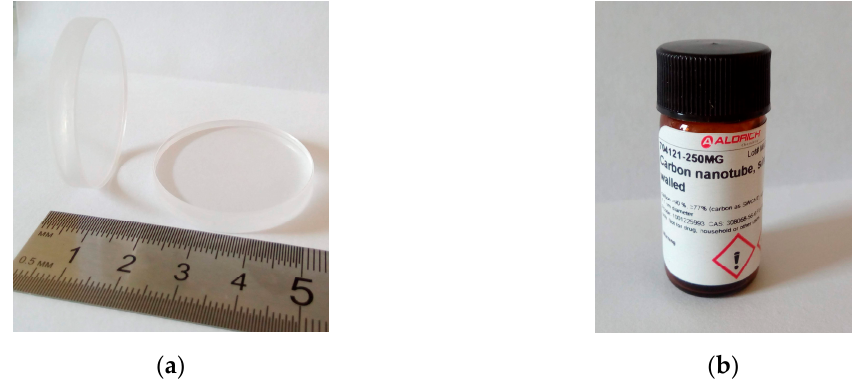
Figure 4. KBr substrates ( a ) and the carbon nanotube (CNT) mixture, type #704121 ( b ).